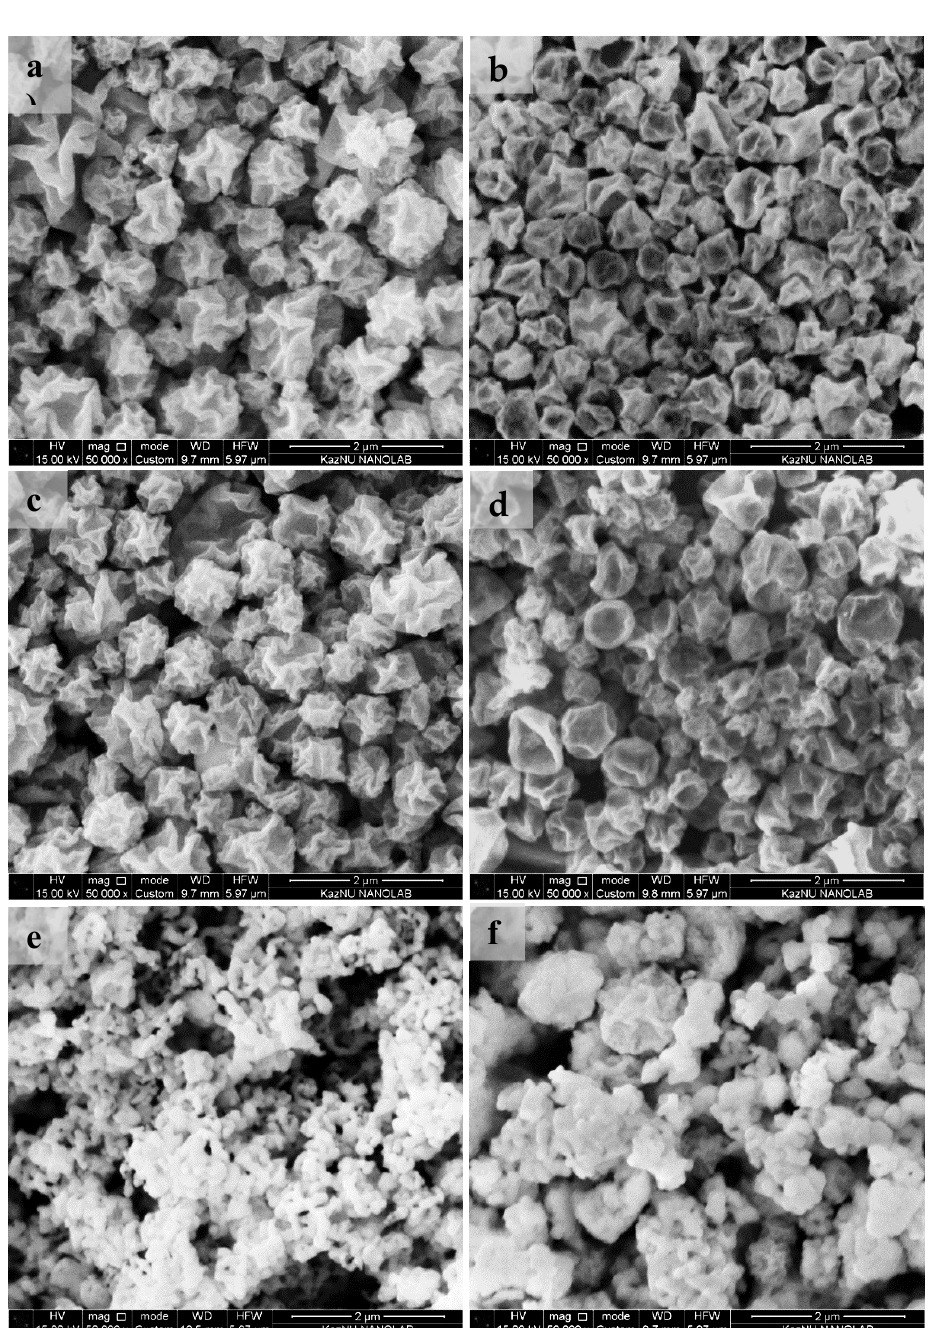
Figure 2. SEM images of Co 3 O 4 and reduced Co 3 O 4 nanoparticles obtained by: the pyrolysis of ( a ) a 0.12-M solution of cobalt acetate tetrahydrate Co(CH 3 COO) 2 · 4H 2 O (AcCo) and ( b ) a 0.06-M solution of AcCo at 500 ◦ C. The pyrolysis of a 0.12-M solution of AcCo at the synthesis temperatures of: ( c ) 500 ◦ C and ( d ) 350 ◦ C. The hydrogen annealing of the Co 3 O 4 powder synthesized from the pyrolysis of a 0.06-M solution of AcCo at 350 ◦ C at the temperatures of: ( e ) 250 ◦ C and ( f ) 300 ◦ C.